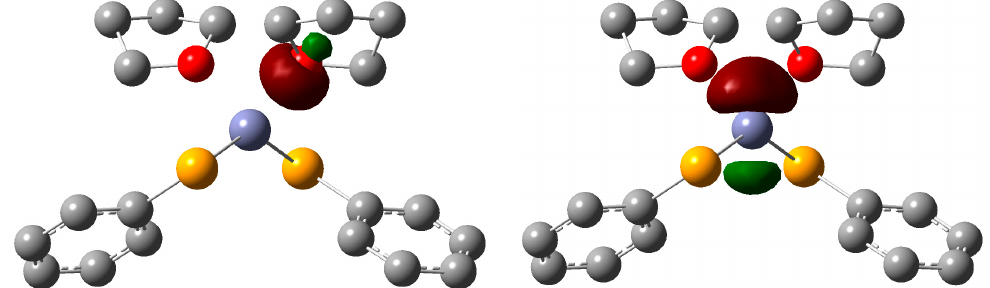
Figure 2. Drawings of the NBOs involved in the second order interaction between (PhSe) 2 Zn and the THF fragments in the compound (PhSe) 2 Zn·2THF at the DFT-optimized geometry (energy difference 0.7465 a.u.; interaction energy 25.77 kcal·mol –1 ). Left : filled NBO LP localized on the oxygen donor atom of one THF solvent fragment (NBO #127, 34.45% s and 65.54% p character). Right : virtual NBO LP* localized on the Zn center (NBO #124, 9.51% s and 90.35% p character). Cutoff value: 0.1 |e|. Hydrogen atoms have been omitted for clarity. (Grey = Carbon; Red = Oxygen; Yellow = Selenium; Violet = Zinc)